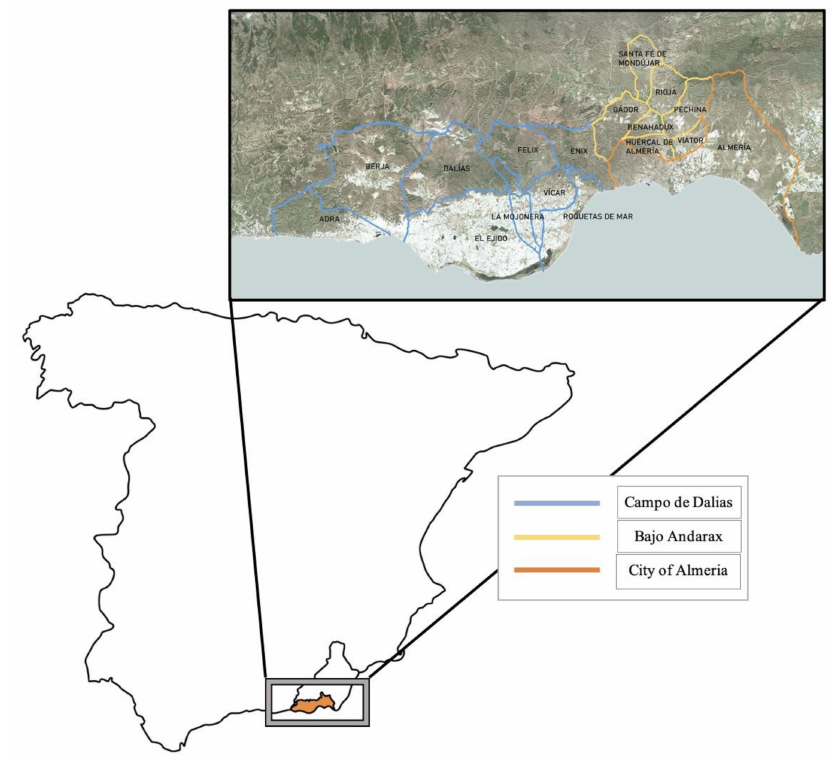
Figure 1. Area of study adapted from Fototeca Digital